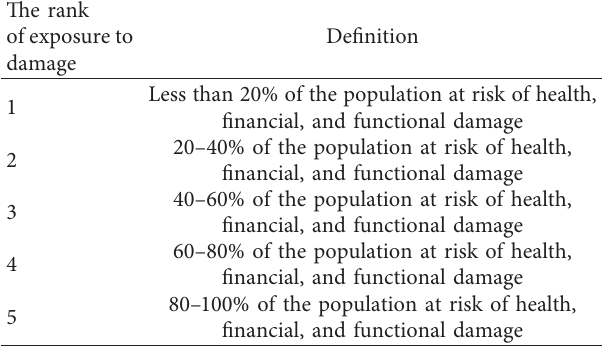
Table 1: Ranking the hazard according to its probability.